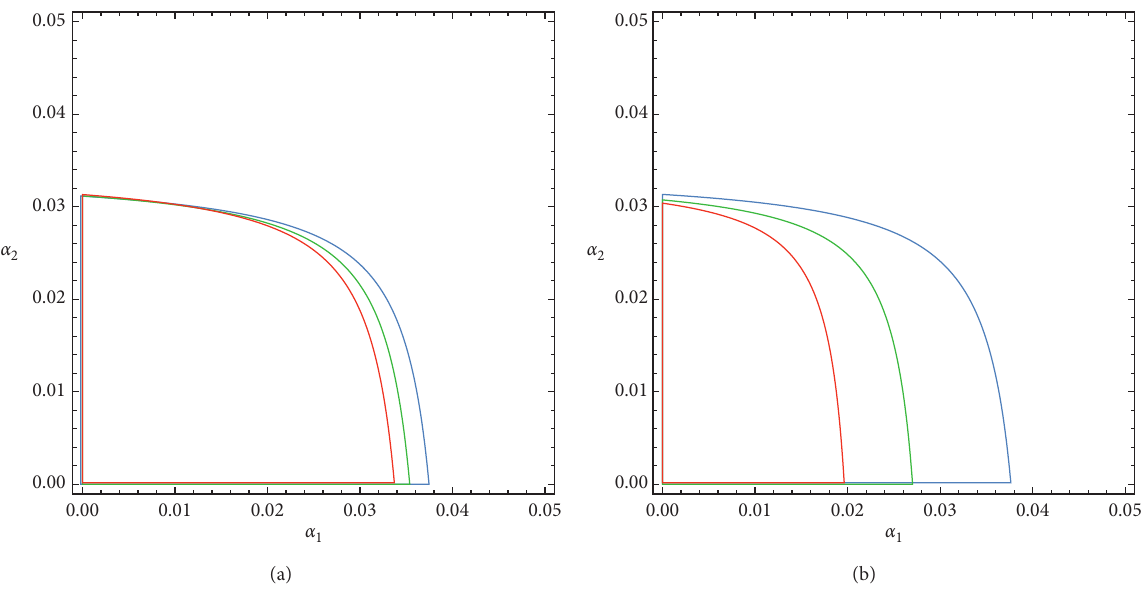
Figure 2: Stable regions of system (17) with different values of (a) λ